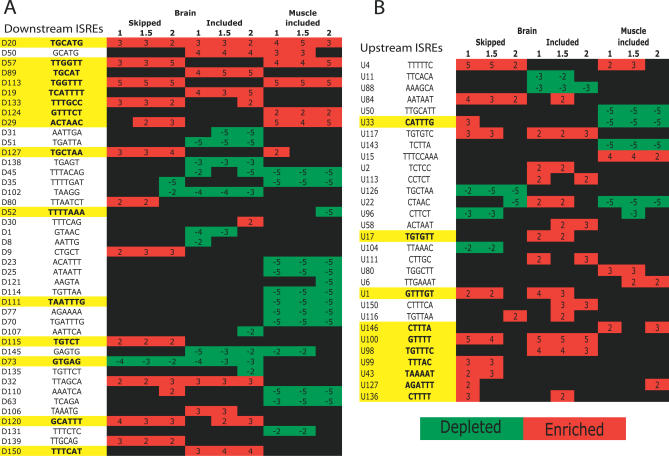
Enrichment and Depletion of ISREs Proximal to Alternative Exons Differentially Included or Skipped in Brain or Muscle from Splicing-Specific Microarray DataIntronic regions upstream and downstream of exons predicted to be included/skipped at different significance levels (see Protocol S1 for details on the dataset). The significance of enrichment (red boxes)/depletion (green boxes) are reported as log10
p values; a plus sign indicates enrichment, and a minus sign indicates depletion. For example, an ISRE represented by GCATG was enriched in intronic regions downstream of brain-included exons at p < 1 × 10−4 (reported as 4). The motifs highlighted in yellow have been experimentally verified to alter splice site choice in our reporter constructs.(A) Downstream ISREs enriched/depleted in the downstream intronic regions.(B) Upstream ISREs enriched/depleted in the upstream intronic regions.